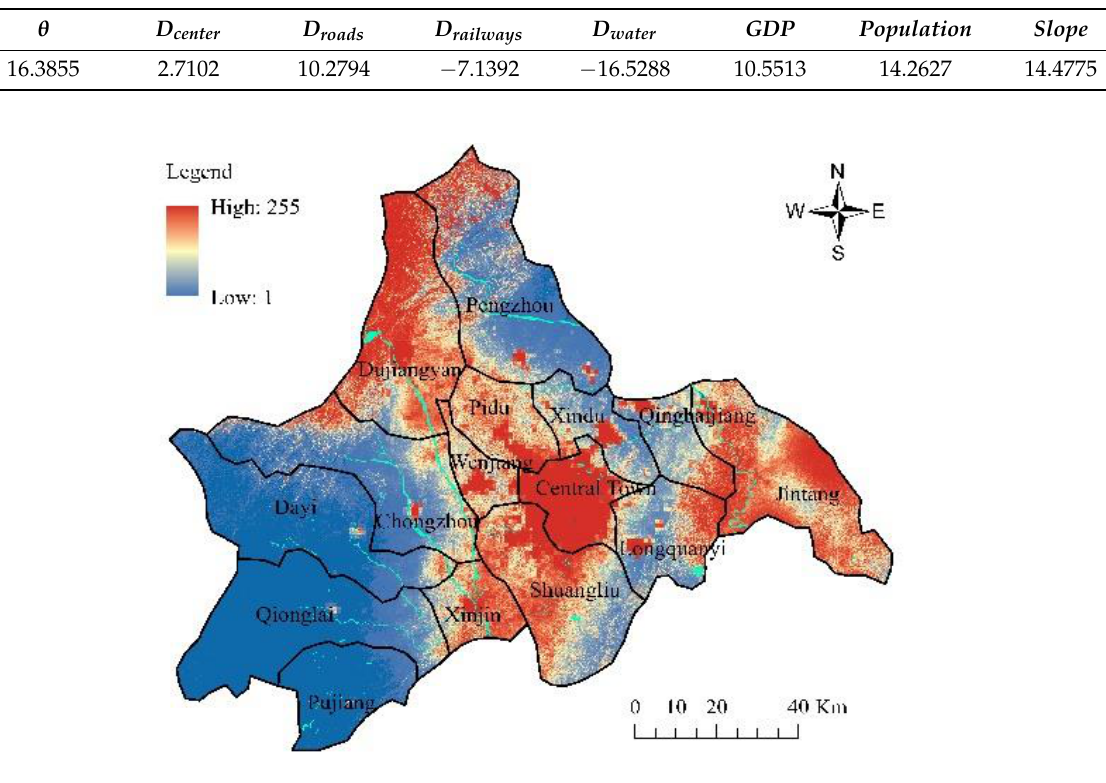
Figure 6. The land transition probability